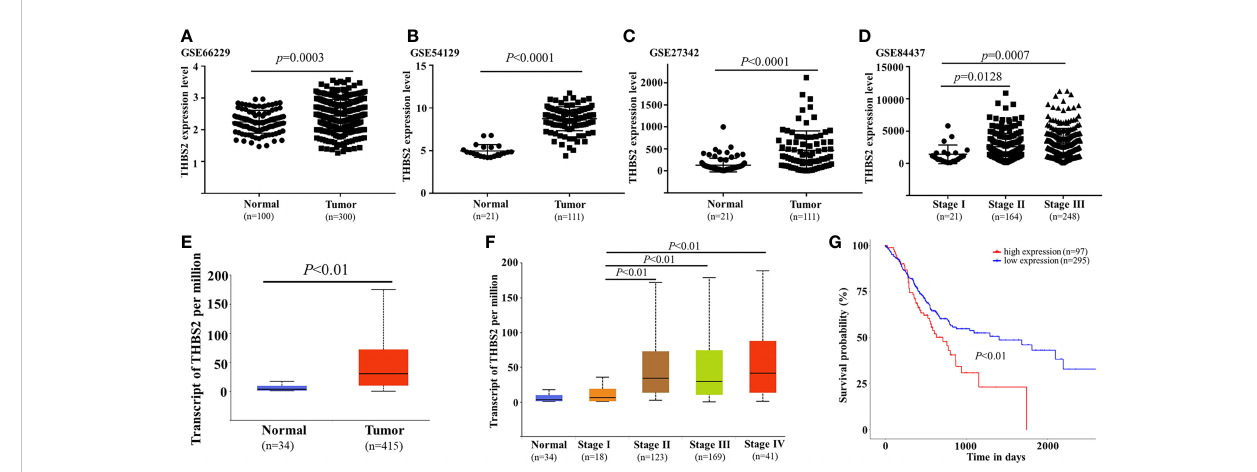
FIGURE 7 Analysis of THBS2 expression dynamics in GC. THBS2 mRNA levels were analyzed in the TCGA (E) and GEO databases ( (A) GSE66229, (B) GSE54129, (C) GSE27342). THBS2 expression was compared across various stages of GC in the TCGA (D) and GEO (F) databases. Patient overall survival as a function of THBS2 expression was analyzed in the TCGA database (G) .